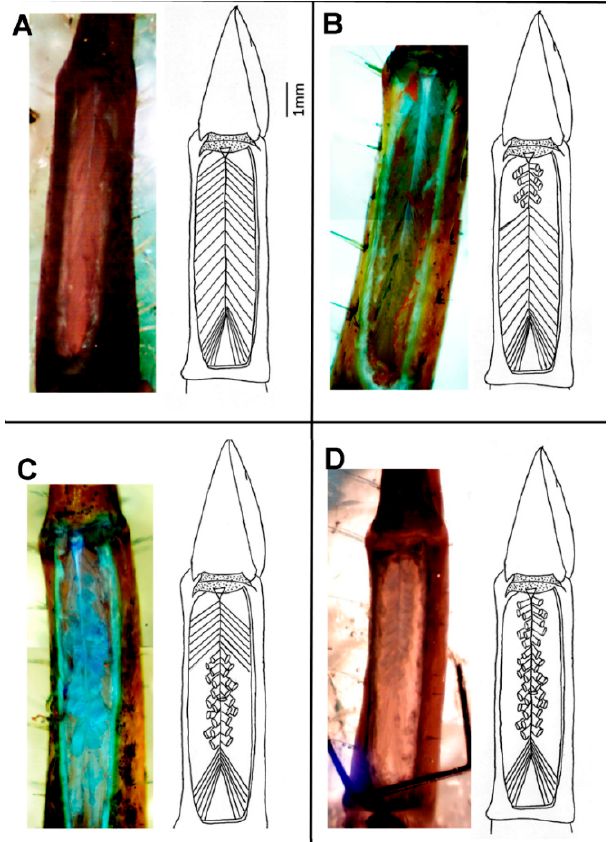
Figure 5. Dorsal dissections of the first walking leg showing ablated tissue: The photographs show the ablated fibers are stained more darkly by methylene blue than the intact fibers. Four different dissections were performed: ( A ) intact opener muscle control, ( B ) ablated distal fibers, ( C ) ablated central fibers, and ( D ) ablated distal and central fibers.